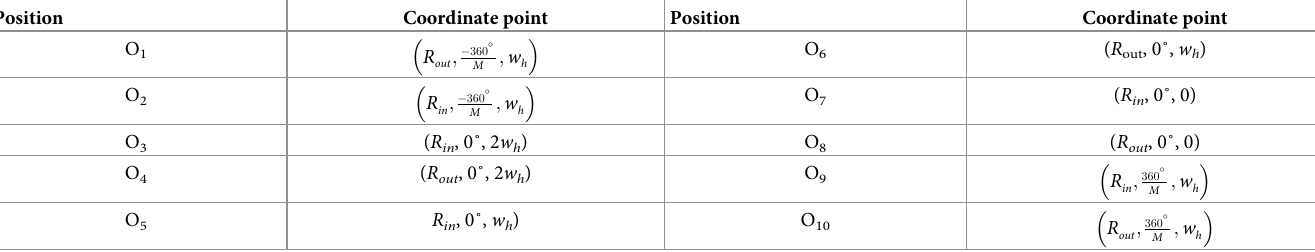
Table 3. Coordinates of O i point in cylindrical coordinate system.